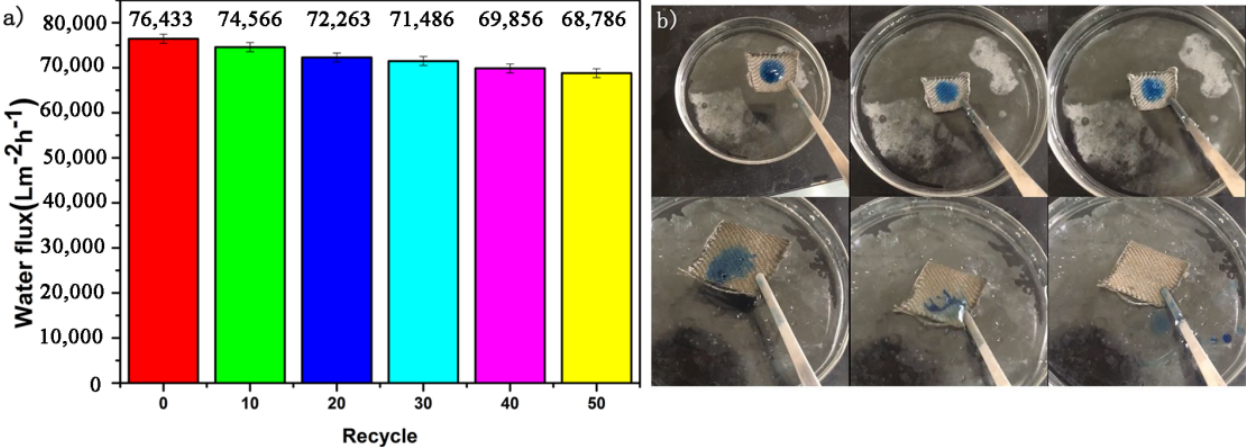
Figure 5. Variation of water flux with the number of recycles ( a ) and self-cleaning performance ( b ).